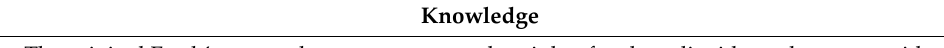
Table 3. Example of knowledge.